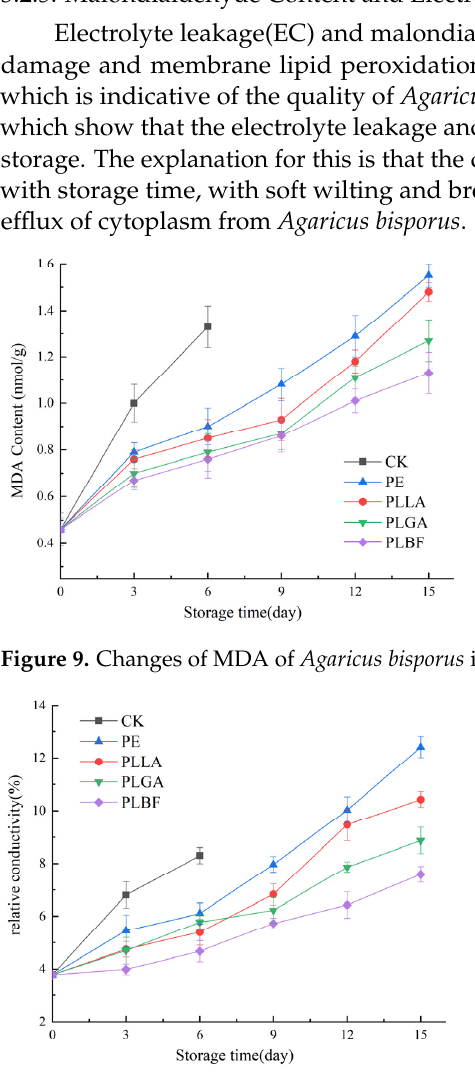
Figure 10. Changes of relative conductivity of cell membrane of Agaricus bisporus in each group during storage.